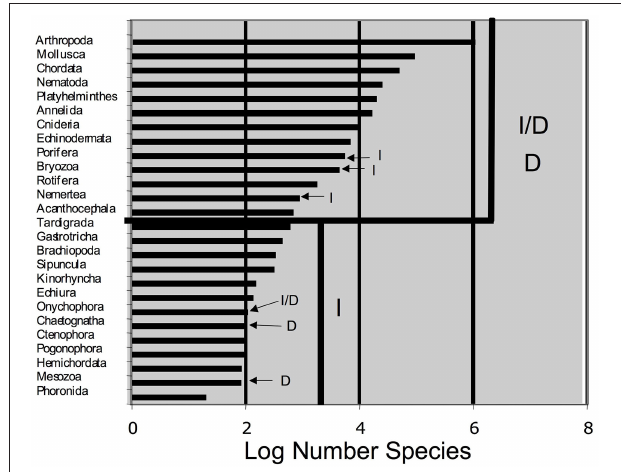
TABLE 1 | Number of species and PGC development mode per phylum.